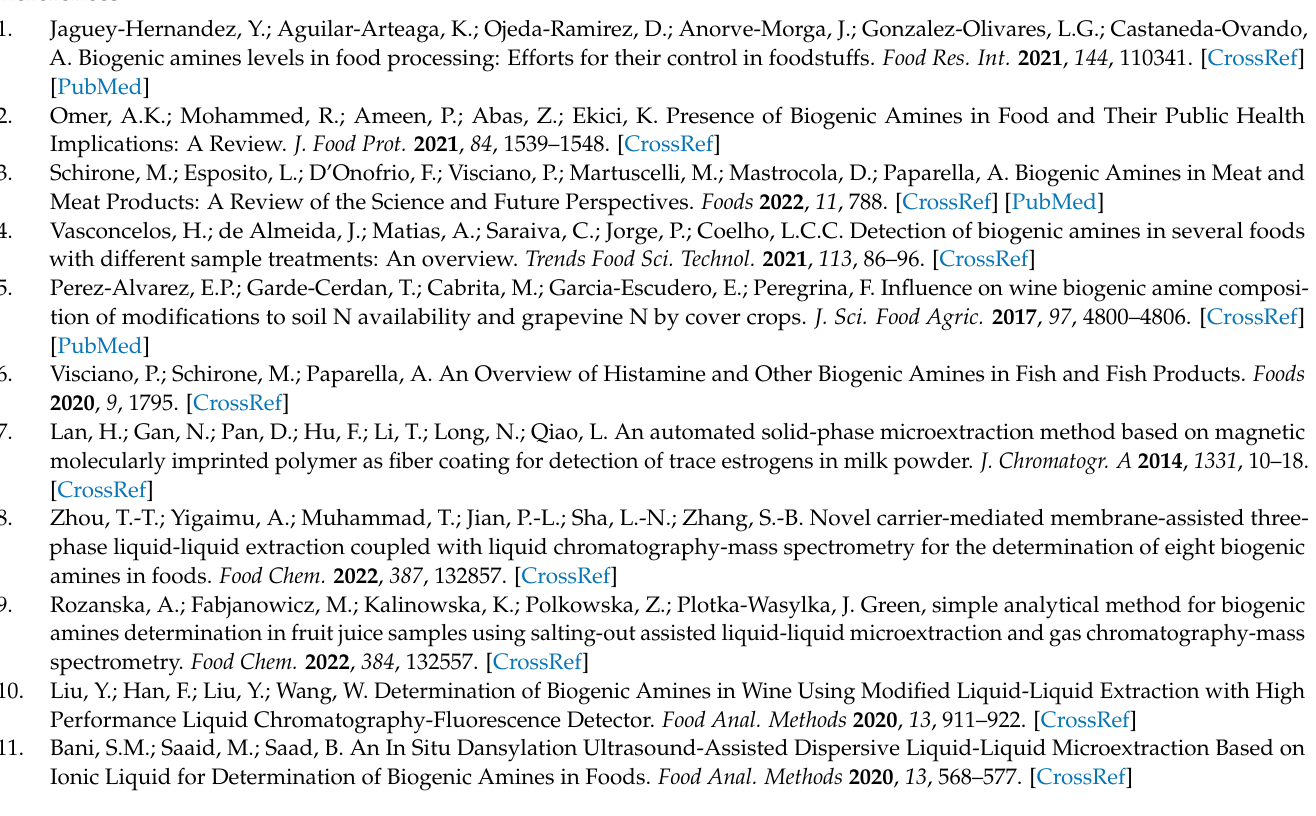
Arrow used 10 times; ( d ) MCM–T–H–SPME Arrow used 50 times; and ( e ) coating thickness; Figure S4: Comparison of extraction efficiency between MCM–T–H and DVB/CAR/PDMS-coated SPME Arrows; Figure S5: Schematic representation of the derivatization of BAs with isobutyl chloro- formate; Figure S6: Variations of the biogenic amines content in pork over 7 days; Figure S7: Variations of the biogenic amines content in mackerel over 7 days; Figure S8: GC chromatograms ( A ) and mass spectrums ( B ) of pork and mackerel; Table S1: Textural properties of MCM–41 series materials; Table S2: Fragments, retention times, and structural formulas for the procedure of determination of BAs based on the application of the GC–MS